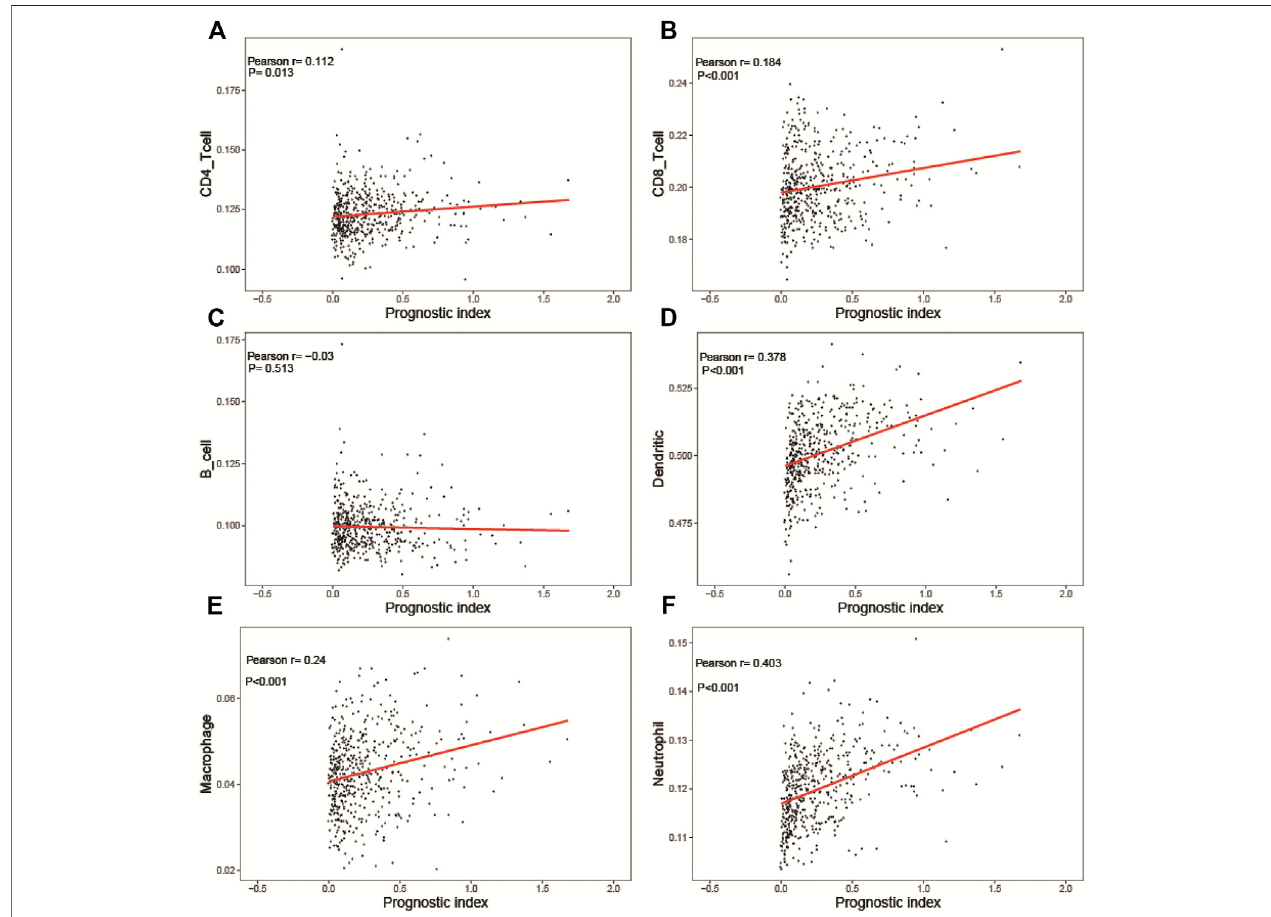
FIGURE 10 | Relationships between the immune-related prognostic index and immune cell in fi ltration. (A) CD4 T cells; (B) CD8 T cells; (C) B cells; (D) dendritic cells; (E) macrophages; (F) neutrophils.